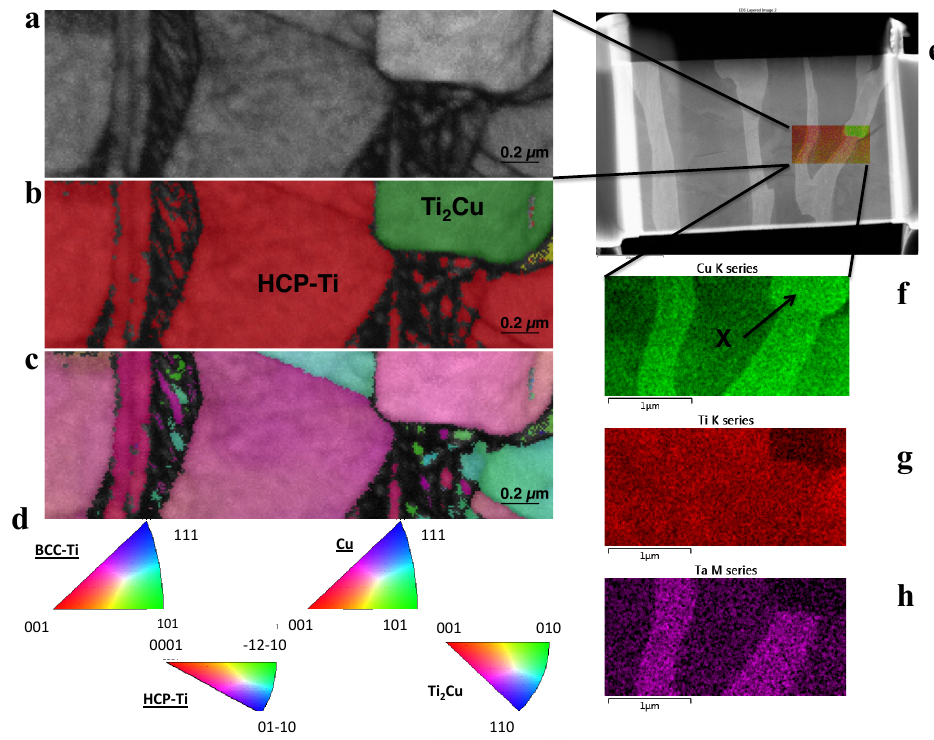
Figure 5 . 3 wt.% Cu alloy studied using TKD and EDS. From the TKD study ( a ) displays band contrast, ( b ) a phase map and ( c ) IPF Z map of the same area with ( d ) associated pole figures. ( e ) An electron image of the area investigated with both techniques, ( f–h ) EDS maps of: ( f ) Cu K series (where X indicates Ti 2 Cu), ( g ) Ti K series and ( h ) Ta M series.